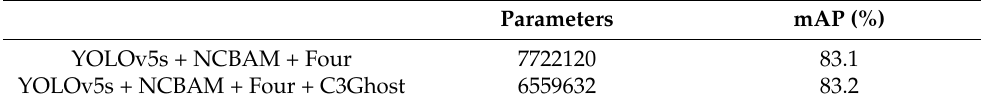
Table 5. Comparison of parameters and performance after C3Ghost module replacement.